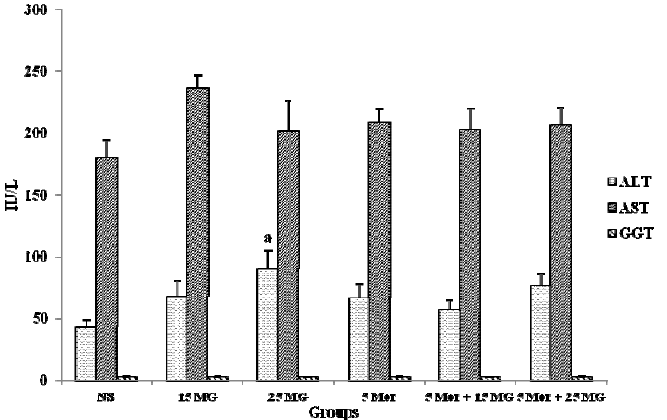
Figure 5. The activities of aspartate aminotransferase (AST), alanine aminotransferase (ALT) and gamma-glutamyltransferase (GGT) in control group (Normal saline), mitragynine (15 mg/kg, 25 mg/kg), morphine (5 mg/kg) and combination groups (5 mg/kg Mor + 15 mg/kg; 5 mg/kg Mor + 25 mg/kg). Each column represents the mean ± SEM of IU/L of seven animals in each group (n = 7).